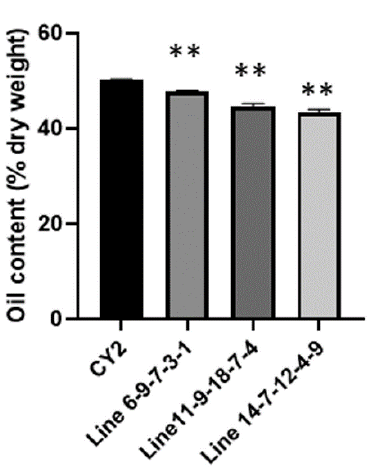
Figure 3. Oil content in seeds of the T 4 generation edited lines. Mature seeds were used for analysis